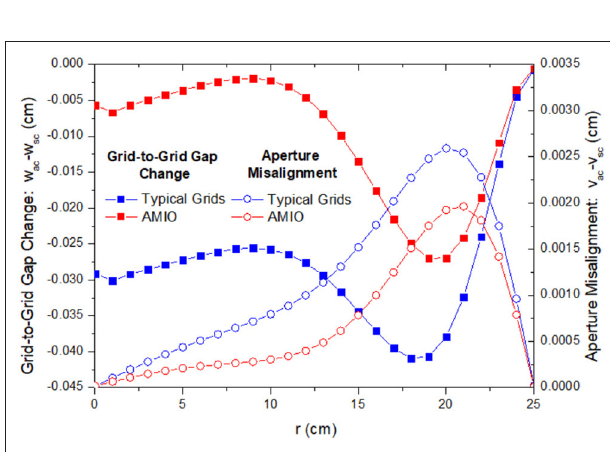
FIGURE 7 | Normal and tangential displacements for typical ion optics and for AMIO.